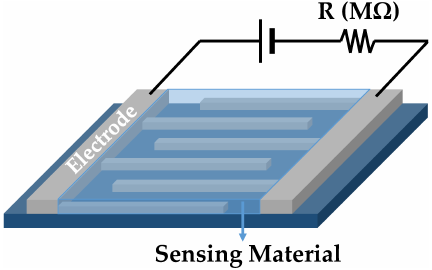
Figure 3. Schematic view of a chemiresistor sensor that measures the sensing material resistance changes between the two interdigited electrodes when exposed to the desired